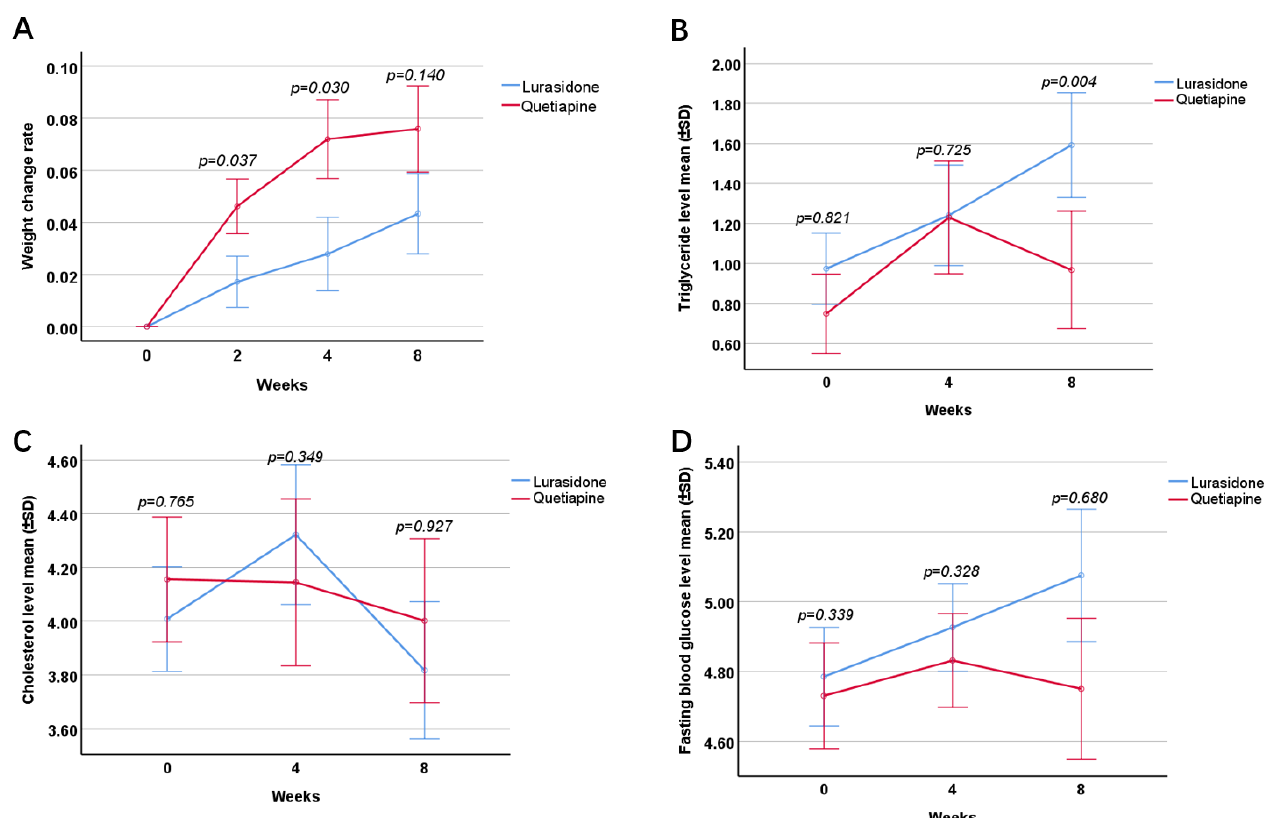
Figure 2. Comparison of metabolic profiles between the two treatment groups. Comparison of the rate of change in body weight between the two groups at the end of 2, 4, and 8 ( A ); comparison of triglyceride levels between the two groups at baseline, 4 and 8 weeks ( B ); comparison of cholesterol levels between the two groups at baseline, 4 and 8 weeks ( C ); comparison of fasting blood glucose levels between the two groups at baseline, 4 and 8 weeks ( D